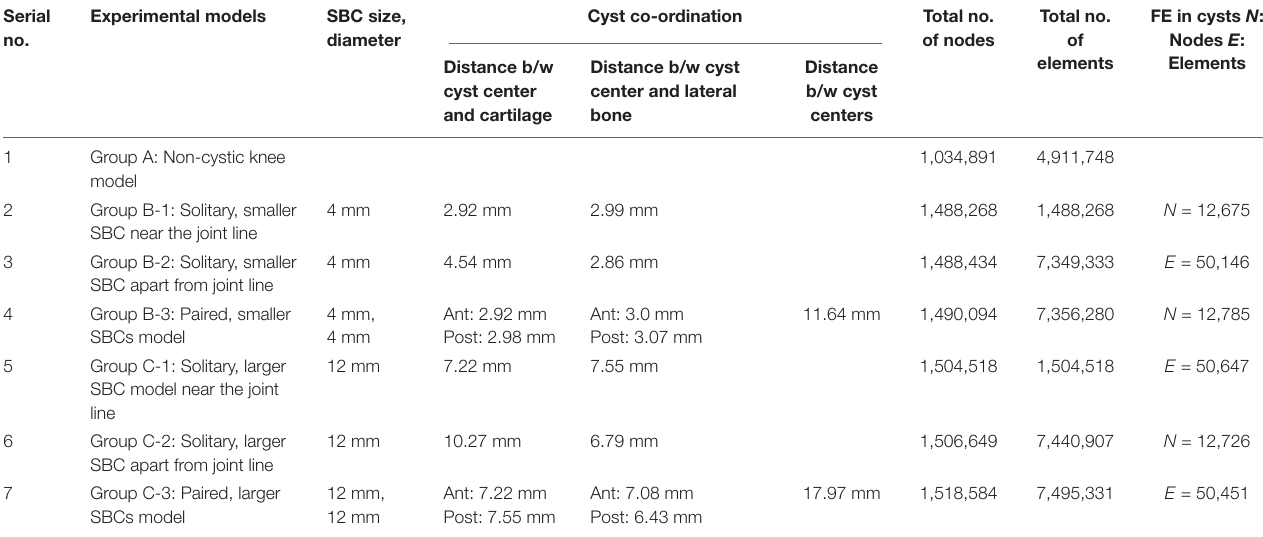
TABLE 2 | Detail of SBCs parameters and nodes and elements in different models. Serial Experimental models no.